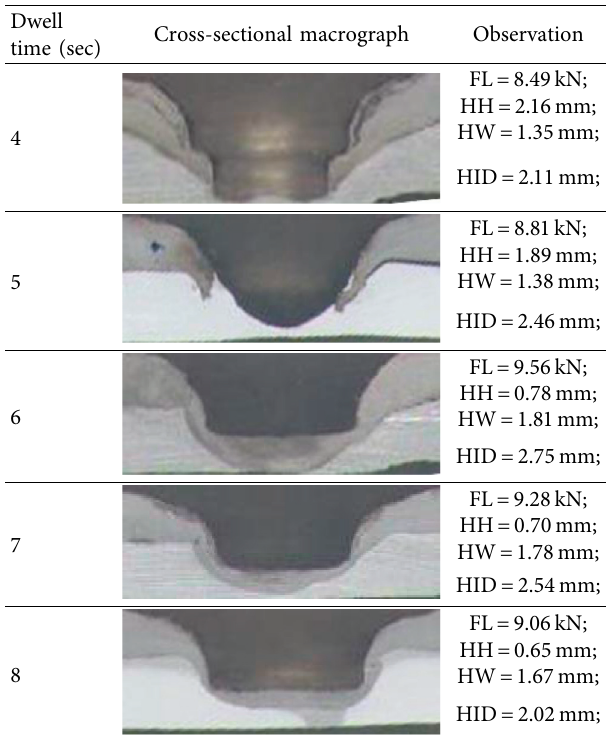
Table 4: Influence of dwell time on macrograph of FSSW dissimilar joints.